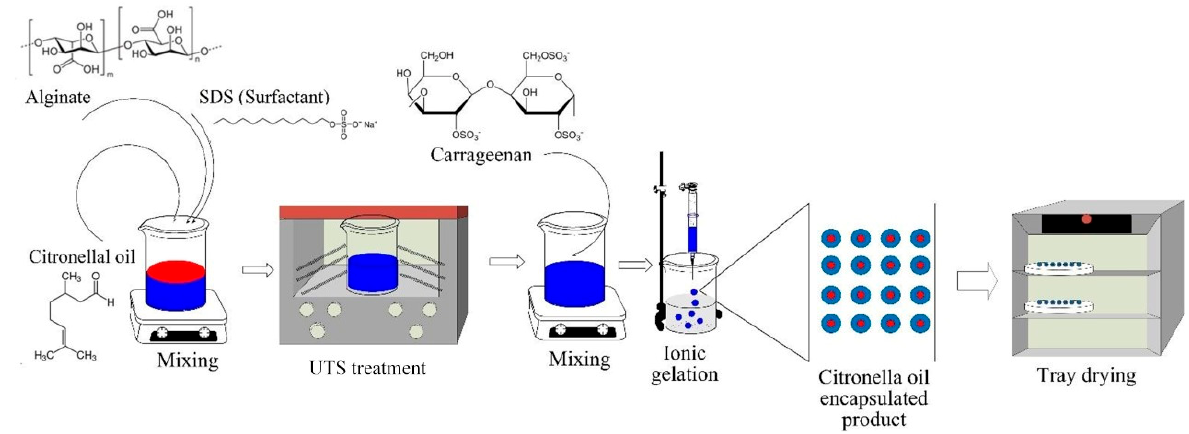
Figure 1. Experimental setup of ultrasound-assisted encapsulation .